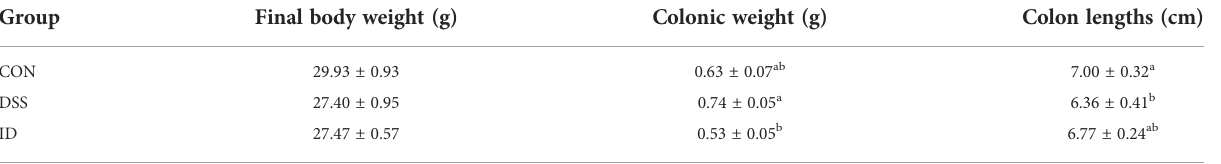
TABLE 1 Effects of IPA pretreatment on the growth performance of DSS-induced mice.